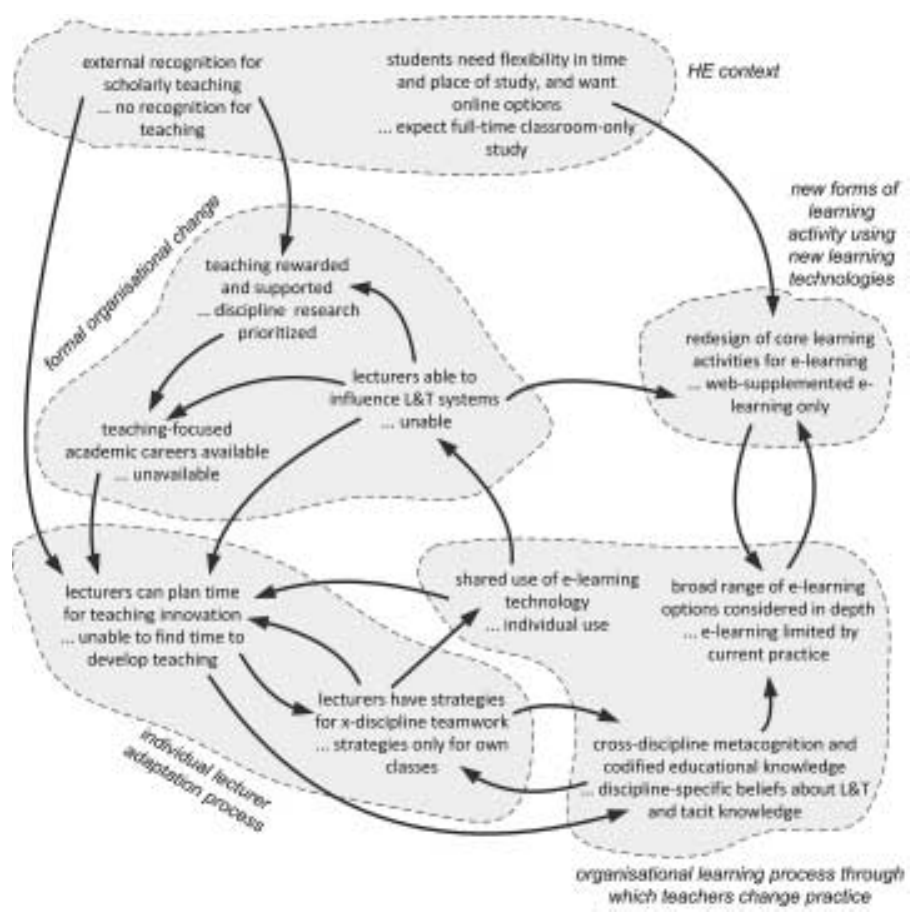
Figure 4. Contextual influences on individual teachers’ strategies in